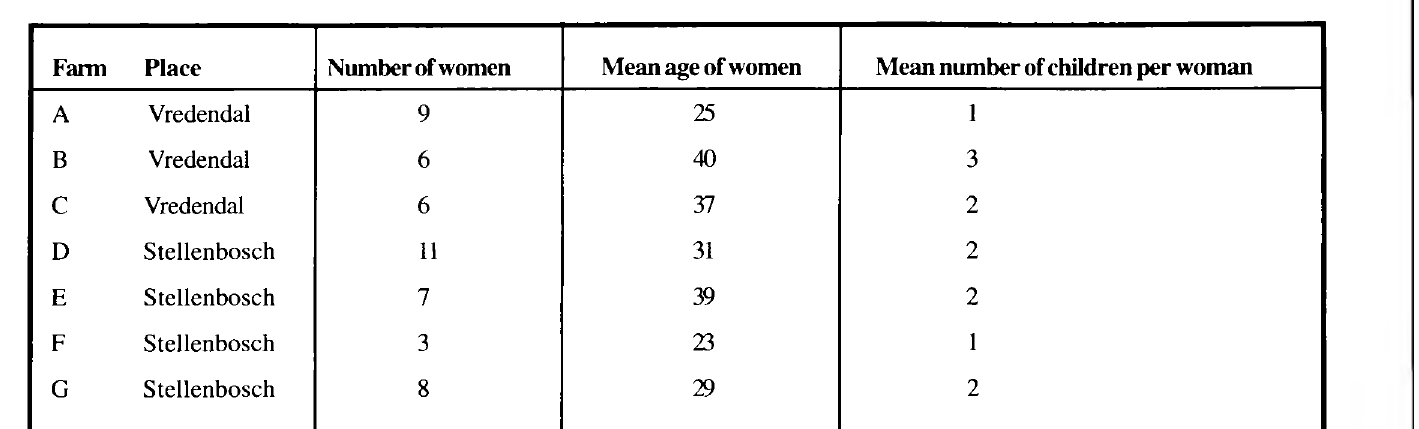
Table 1a: Description of Women’s Focus Groups Farm